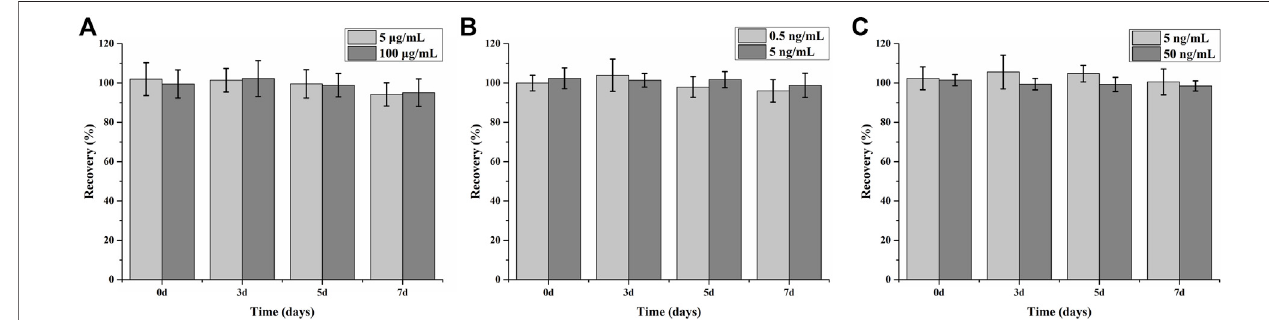
FIGURE 6 | Long-term stability of assay for CRP (A) , PCT (B), and NGAL (C) detection ( n = 6).